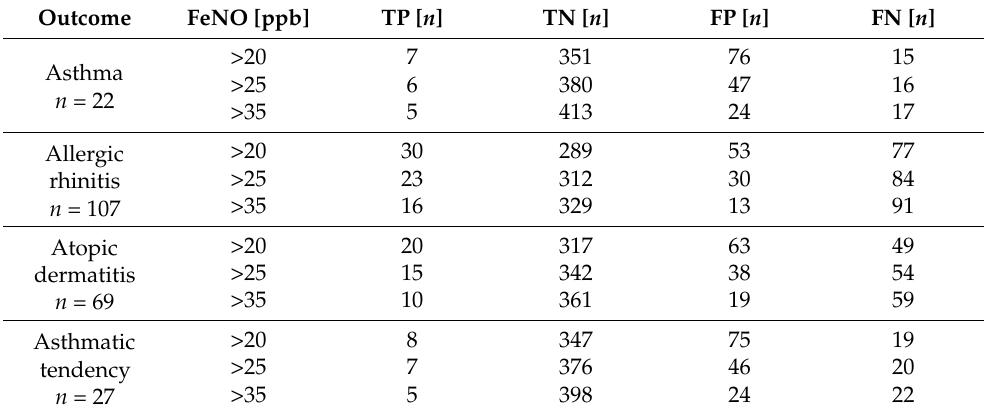
Table 2. Frequency ( n ) of true positives (TP), true negatives (TN), false positives (FP), and false negatives (FN) of three FeNO cutoffs for the study outcomes.